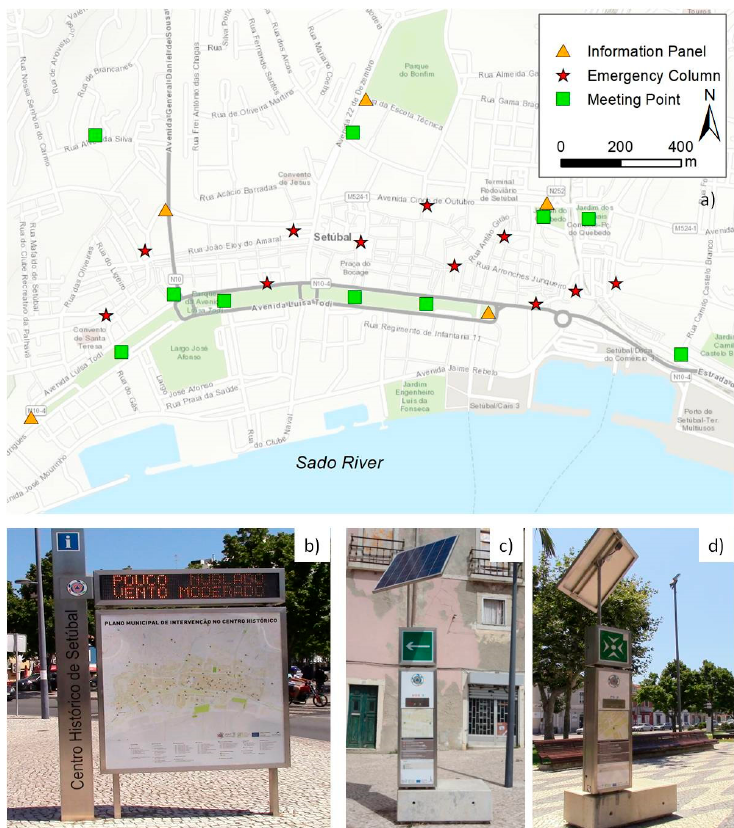
Figure 5. Municipal Plan of Intervention to the Historic Center (adapted from [22]). See location of the urban area in Figure 1: ( a ) Location of the installed signs; ( b ) information panel; ( c ) emergency column; ( d ) meeting point.